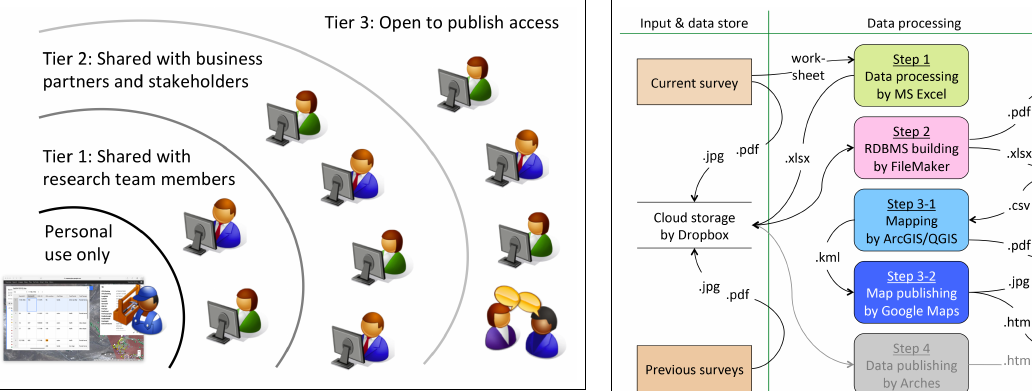
Figure 1: Data access tiers of the BatDHI.